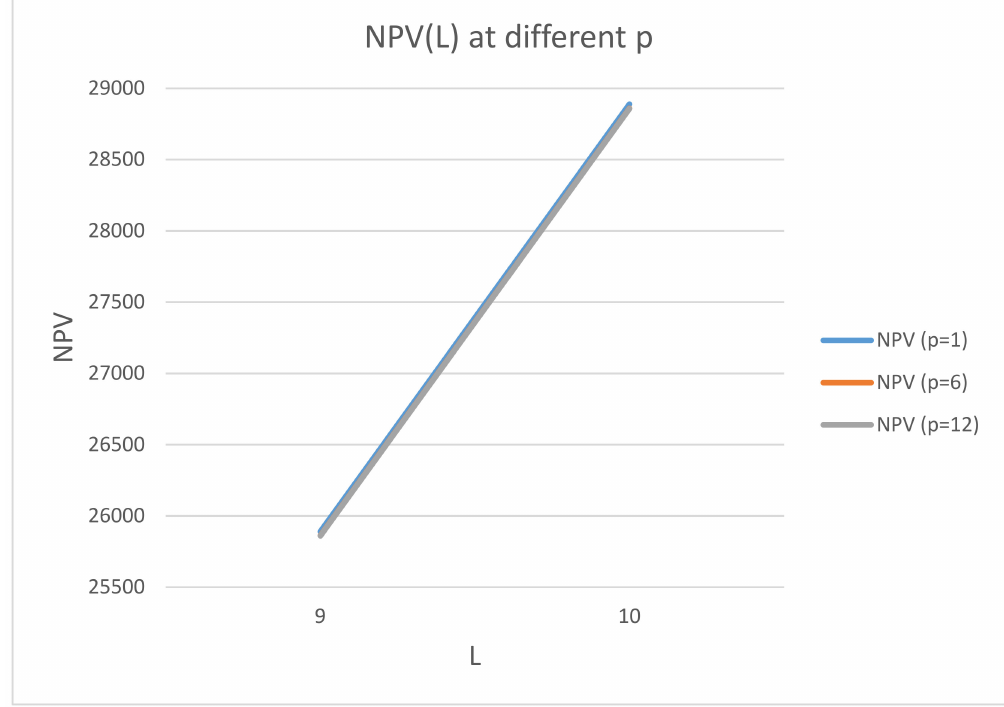
Figure 5. Dependence of NPV on leverage level L at k 0 = 0.22, k d = 0.14 and different p = 1, 6, 12 for a long-term project (larger